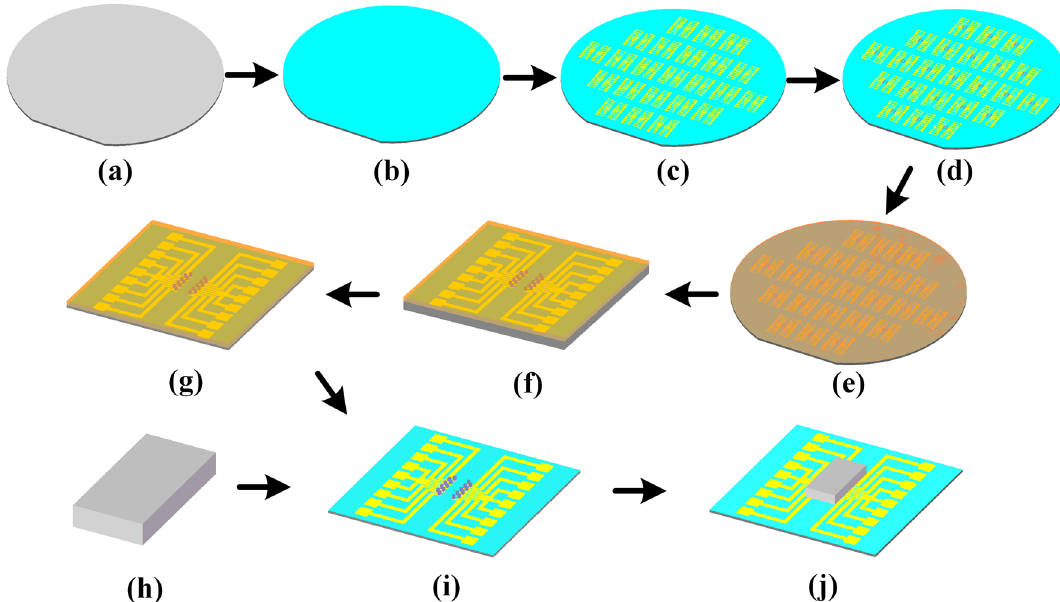
Figure 3. Fabrication processing flow of the bonding structure. ( a ) Sample wafer. ( b ) SiO 2 passivation layer was deposited on the surface by PECVD. ( c ) Sputtering of the electrode and bonding pads. ( d ) In layer evaporated onto the bonding pads. ( e ) Photoresist coated. ( f ) Scribing. ( g ) Reducing the thickness. ( h ) TMR device. ( i ) Photoresist removed. ( j ) Wafer-level Au-In bonding. (Created by Microsoft Visio 2013 (15.0) and SOLIDWORKS(R) Premium 2016.).